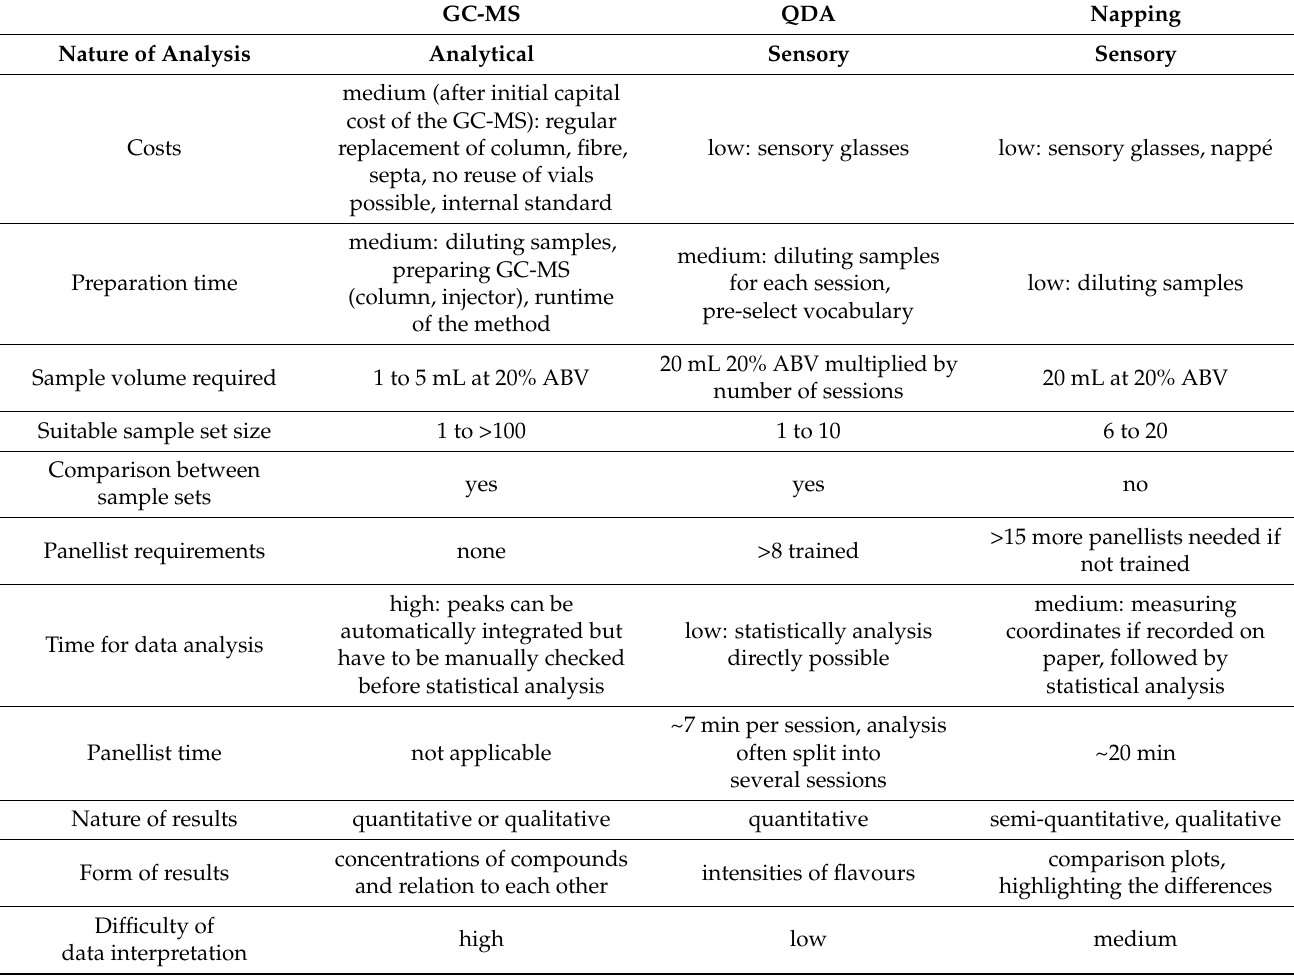
Table 3. Overview of GC-MS, QDA and